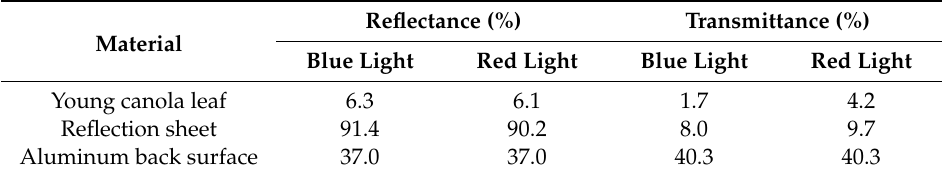
Figure 4. Measured reflectance and transmittance of the canola leaf ( A ) and the reflection sheet (FEB#110, Yupo Corporation, Tokyo, Japan) ( B ). They were measured using a UV-Visible / NIR spectrophotometer (V-750, JASCO Corporation, Tokyo, Japan), with an integrating sphere unit (ISV-922, JASCO Corporation, Tokyo, Japan). Table 1. Reflectance and transmittance values of different materials.